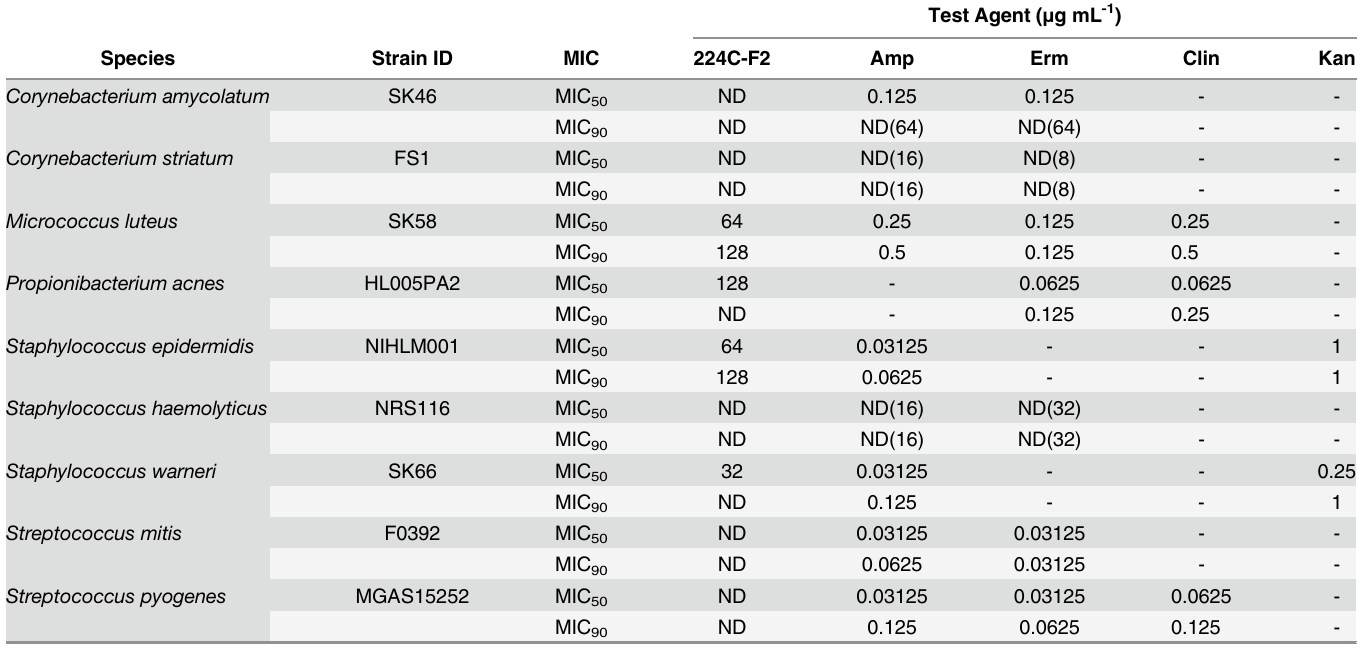
Table 4. 224C-F2 has limited impact on growth of common skin microflora. Minimum inhibitory concentration (MIC) determination for 224C-F2 and anti- biotic controls (ampicillin, erythromycin, clindamycin and kanamycin) against bacterial skin microflora. All MIC values are represented in μ g mL -1